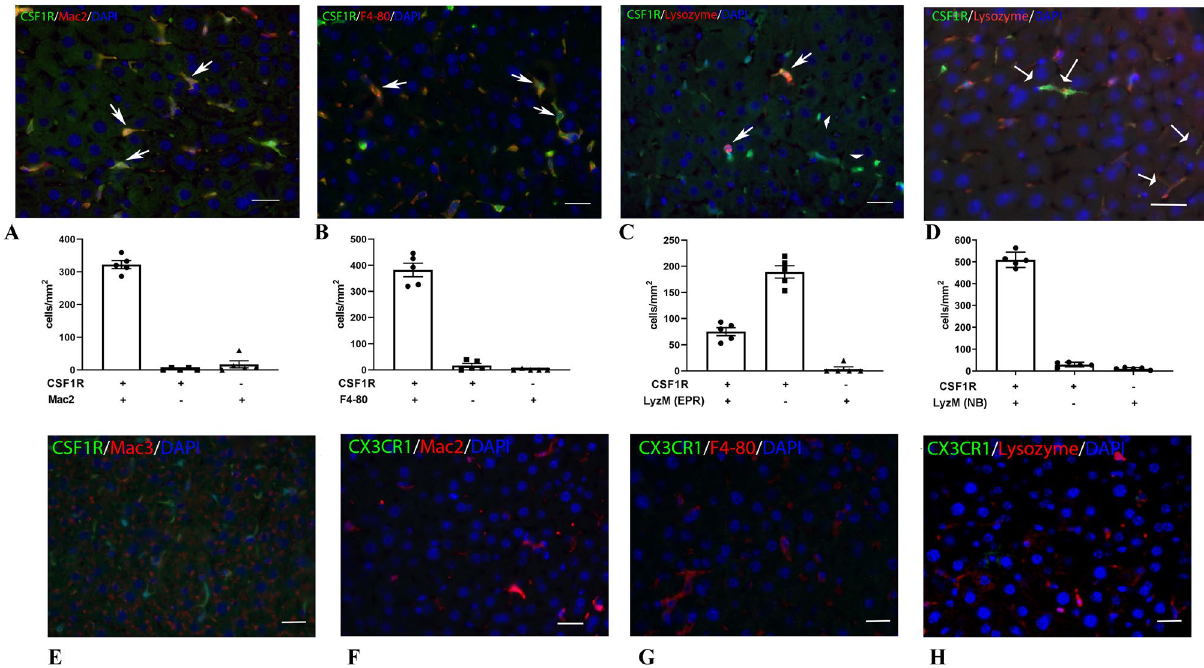
Figure 2. Identification of liver macrophages using antibodies and reporter lines. ( A – C ) Dual labeling for GFP and antibodies to Mac2 ( A ), F4/80 ( B ) and lysozyme M ( C , D ). Arrows show double positive cells. Quantitative analysis shows that Mac2 ( A ) and F4/80 ( B ) co-localize with CSF1R+ cells. In contrast, the majority of CSF1R+ cells are not labeled with the rabbit monoclonal anti-lysozyme antibody EPR2994(2) (EPR, C arrowheads). In order to examine whether the lack of lysozyme immunoreactivity in the majority of hepatic macrophages reflects the low sensitivity of the antibody, we also tested the rabbit polyclonal anti-lysozyme antibody NBP2-61,118 (NB, D). Quantitative analysis showed that virtually all hepatic macrophages exhibited lysozyme immunoreactivity for the NBP2-61,118 antibody. ( E ) A representative image shows that the antibody to Mac3 is not suitable for identification of hepatic macrophages, exhibiting punctate staining throughout the liver. ( F – H ) CX3CR1/Mac2, CX3CR1/F4-80 and CX3CR1/Lysozyme staining confirm the absence of CX3CR1 in hepatic macrophages. Scale bar: 20